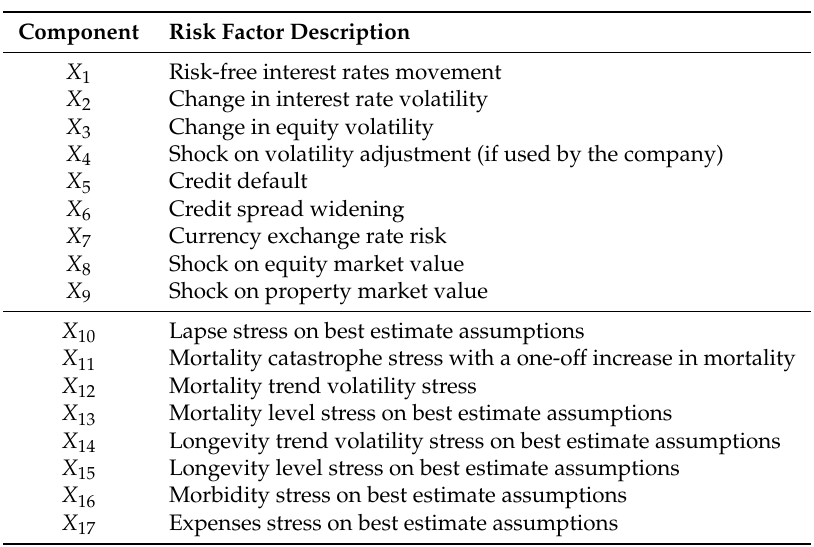
Table 1. Risk factors in the CFP